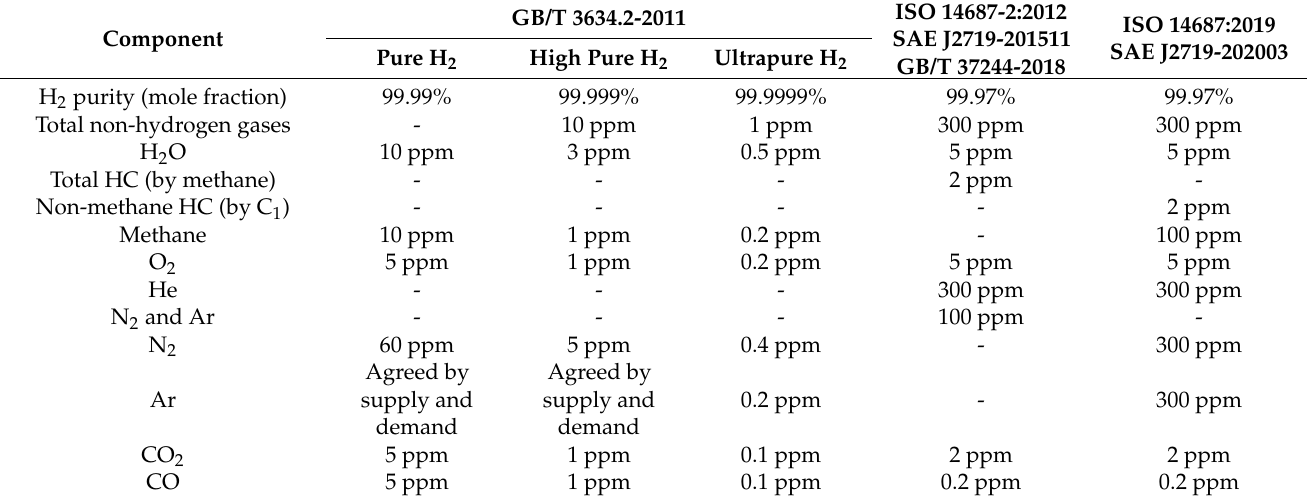
Table 2. Requirements for the impurity content in H 2 for fuel cells in previous and new standards in China and abroad.